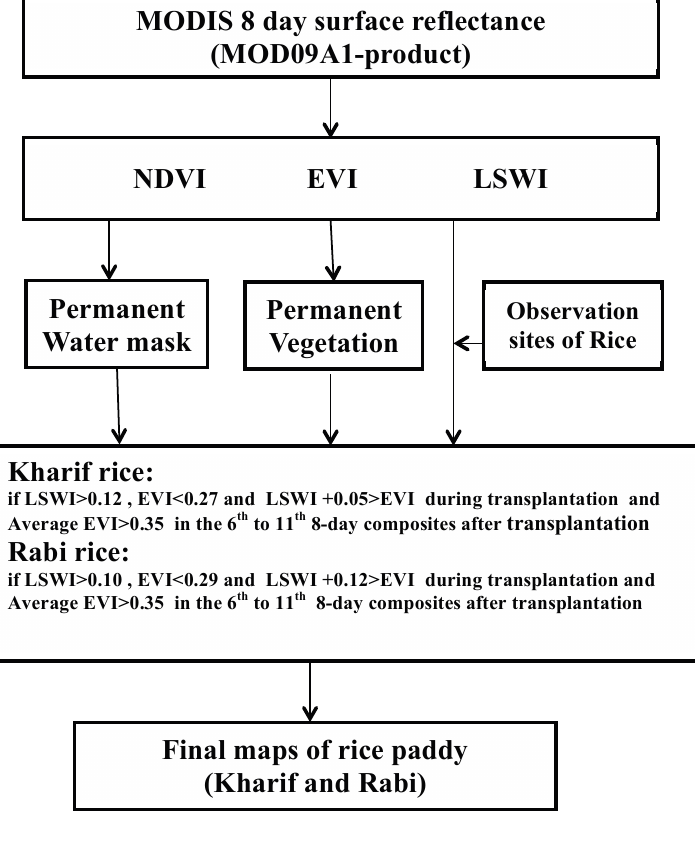
Figure 5. An overview of procedure used for identification of flooded paddy rice using MODIS data for Kharif and Rabi seasons shown in a systematic